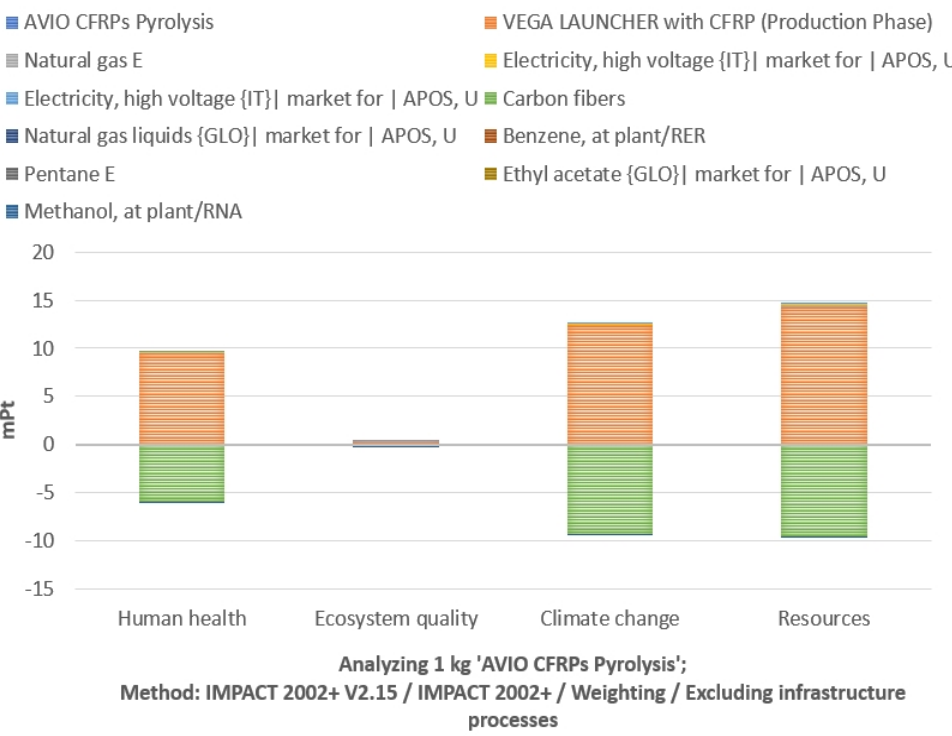
Figure 20. Results of pyrolysis recycling into endpoint categories.